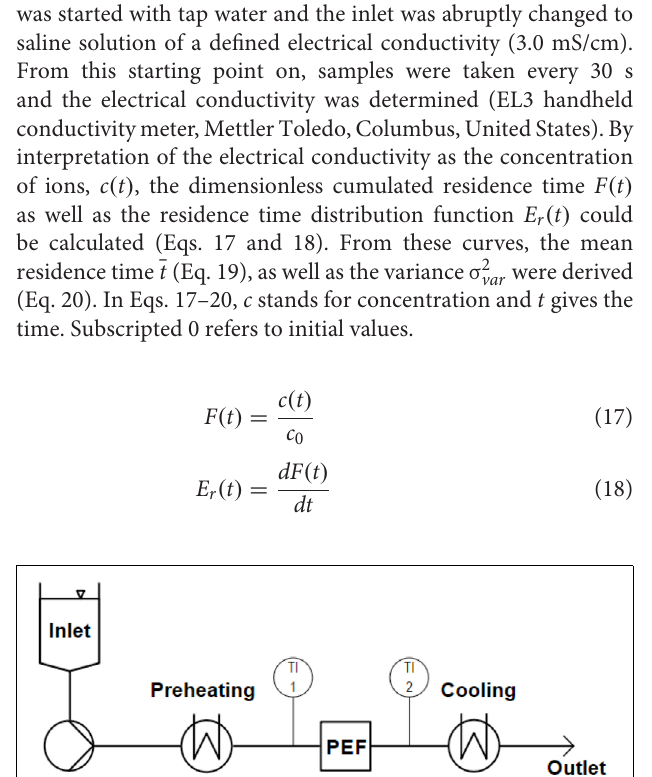
TABLE 3 | Used PEF parameters for the different trials, including voltage ( U ), average electric field strength ( E avg ), maximum current ( I max ), pulse width ( τ p ), maximum pulse repetition rate ( f p , max ), used mass flow ( ˙ m ), inlet temperature ( T in ) as well as maximum outlet temperature ( T out , max ). PEF chamber